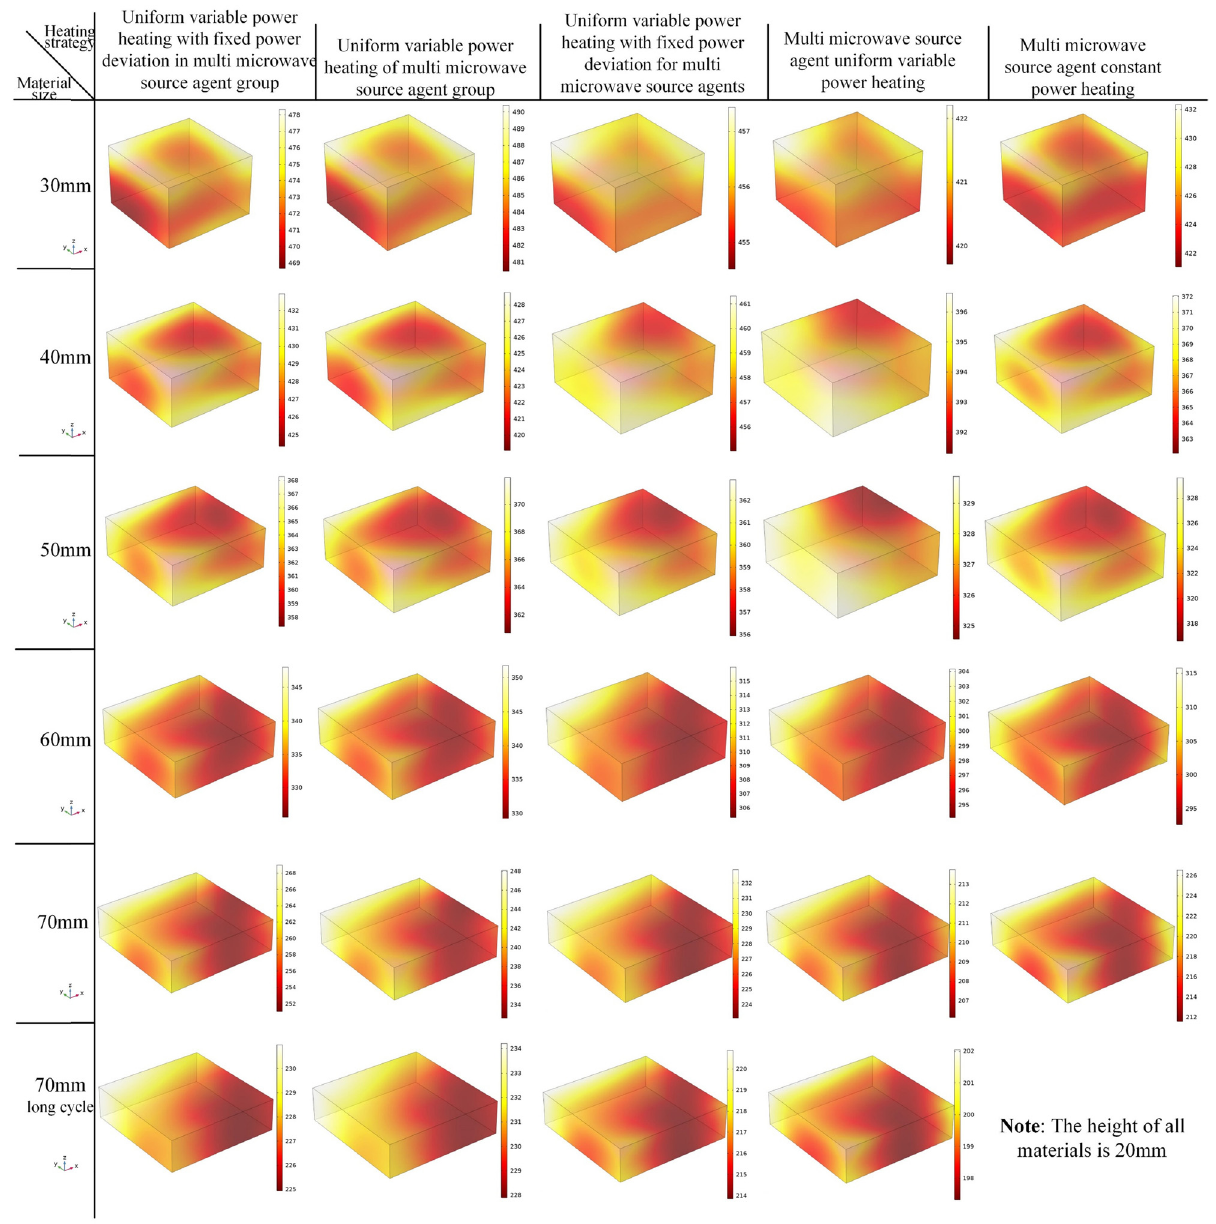
Figure 13: Comparison of the heating e ff ects of materials with di ff erent speci fi